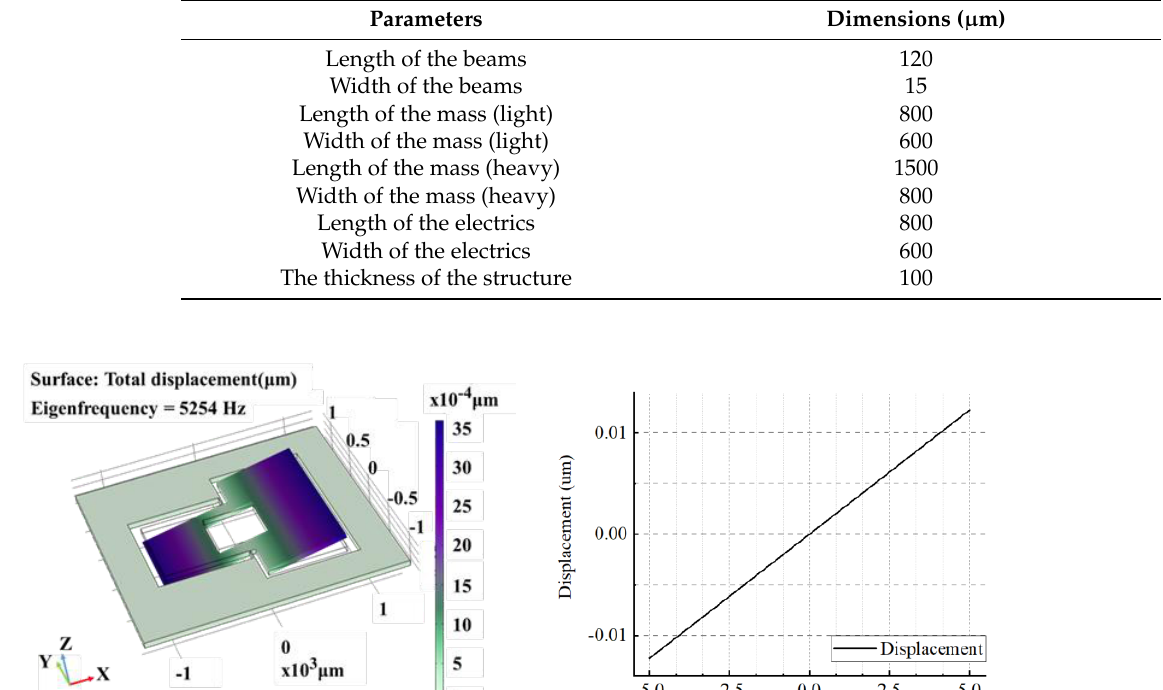
Table 1. The structural parameters of the teeter-totter accelerometer.